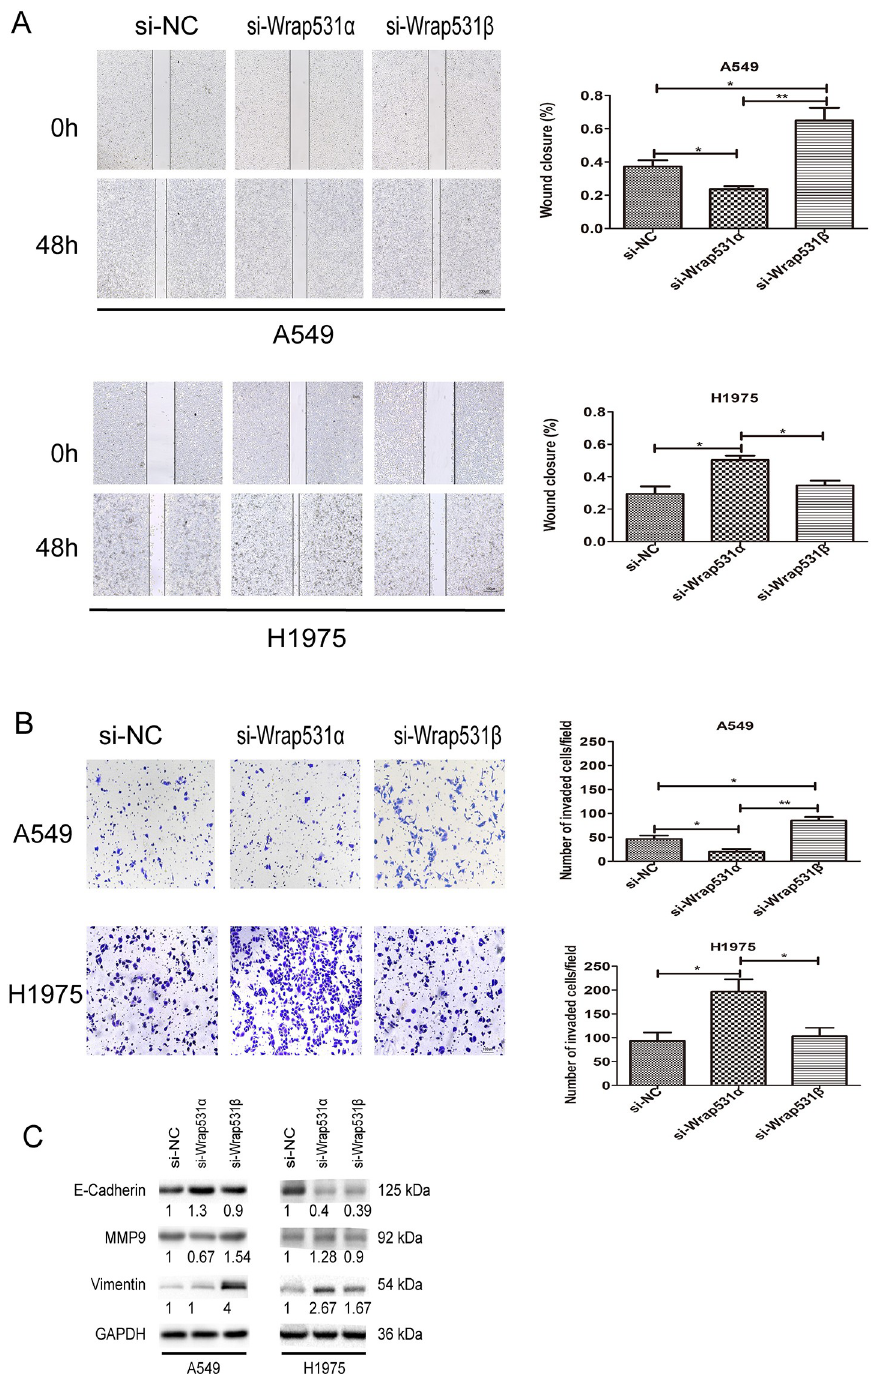
Fig 5. WRAP53 - 1 α and WRAP53-1 β have different effects on the invasion and migration of NSCLC cells. (A) Wound healing assays indicated that knockdown of WRAP53 - 1 α blocked wound closure and that WRAP53-1 β knockdown promoted wound closure in A549 cells. Knockdown of WRAP53 - 1 α accelerated wound closure in H1975 cells. (B) Modified Boyden chamber assays indicated that knockdown of WRAP53 - 1 α reduced cell invasion and that knockdown of WRAP53-1 β increased cell invasion in A549 cells. Knockdown of WRAP53 - 1 α increased invasion in H1975 cells. (C) Protein levels of the invasion-related markers E-cadherin, MMP9, and vimentin were assessed by immunoblotting. Scale bar, 100 μ m. N = 3; � , P < 0.05; �� , P < 0.01.